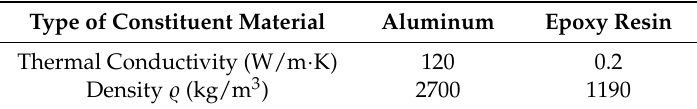
Table 1. Properties of filler and matrix material.